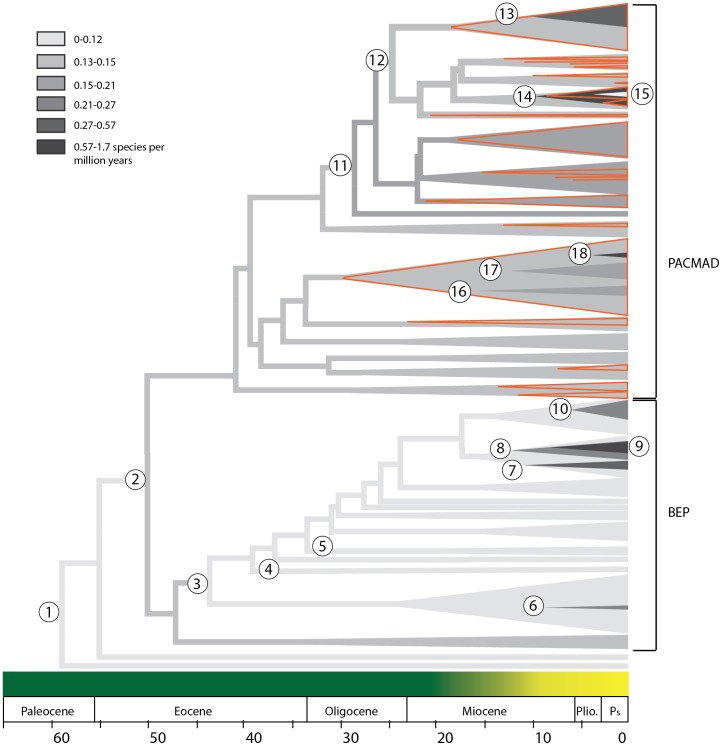
Simplified representation of shifts in diversification rates across Poaceae based on calibration #1.Darker shades of grey indicate higher rates of diversification. Red triangles indicate the approximate phylogenetic placement of C4 lineages. The left point of each triangle corresponds to the stem age of the inferred shift. The transition from dark green to yellow across the bottom indicates the average timing of the rise of open, grassland habitats on different continents [2]. Rate shifts correspond to Table S5 and are labeled as follows: 1) background diversification rate, 2) BEP+PACMAD 3)Bambusoideae+Pooideae, 4) early diverging Pooideae, 5)Phaneospermateae, 6) Perrierbambus+Bonia clade 7) Poeae 2 clade, 8) Poa+Alopecurus clade, 9) Agrostis+Calamagrostis clade, 10) Festuca, 11) Core Panicineae, 12) Andropogoneae+Paspaleae, 13) Sorghum+Andropogon clade, 14) Axonopus+Paspalum clade, 15) Poecilostachys, 16) Eragrostis clade, 17) Spartina clade, 18) Tripogon (Table S5).